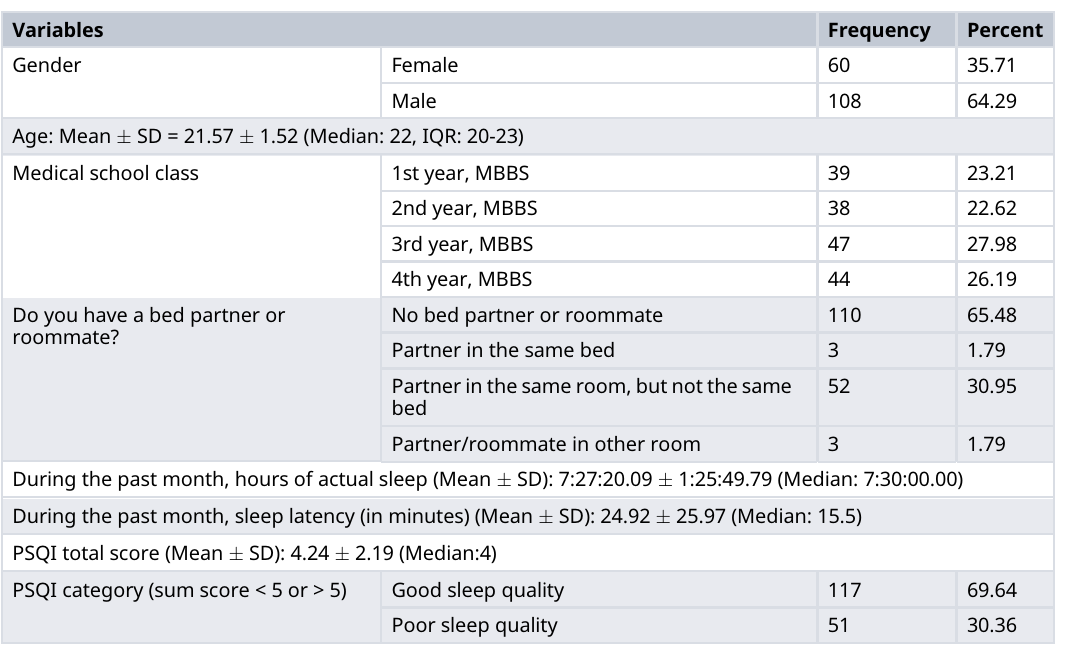
Table 1. Participant ’ s basic details and sleep